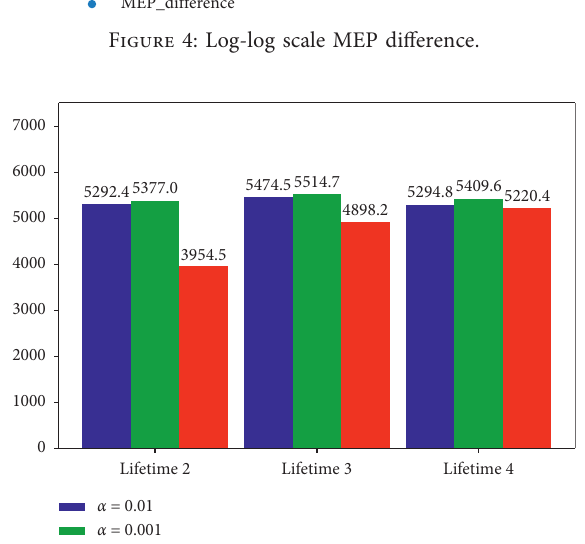
Figure 5: MEP for learning rates α